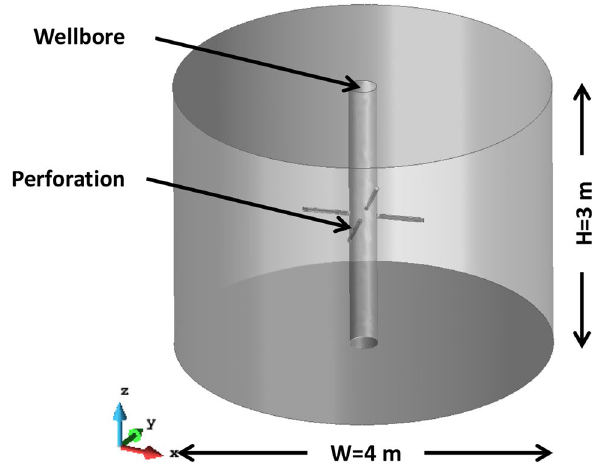
Fig. 19 Geometrical domain of wellbore and perforations Fig. 20 Grid distribution around wellbore (left) and perforations